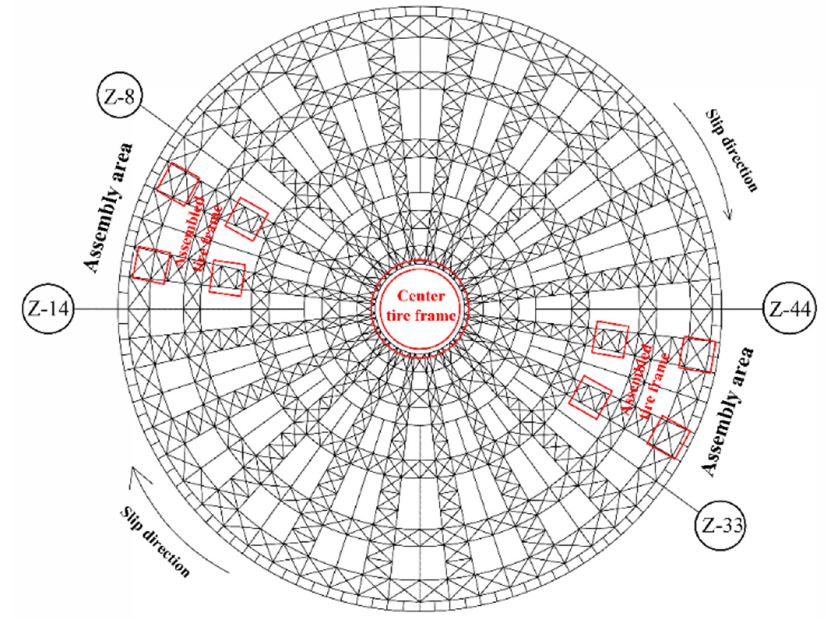
Figure 4. Layout of the Slip site.